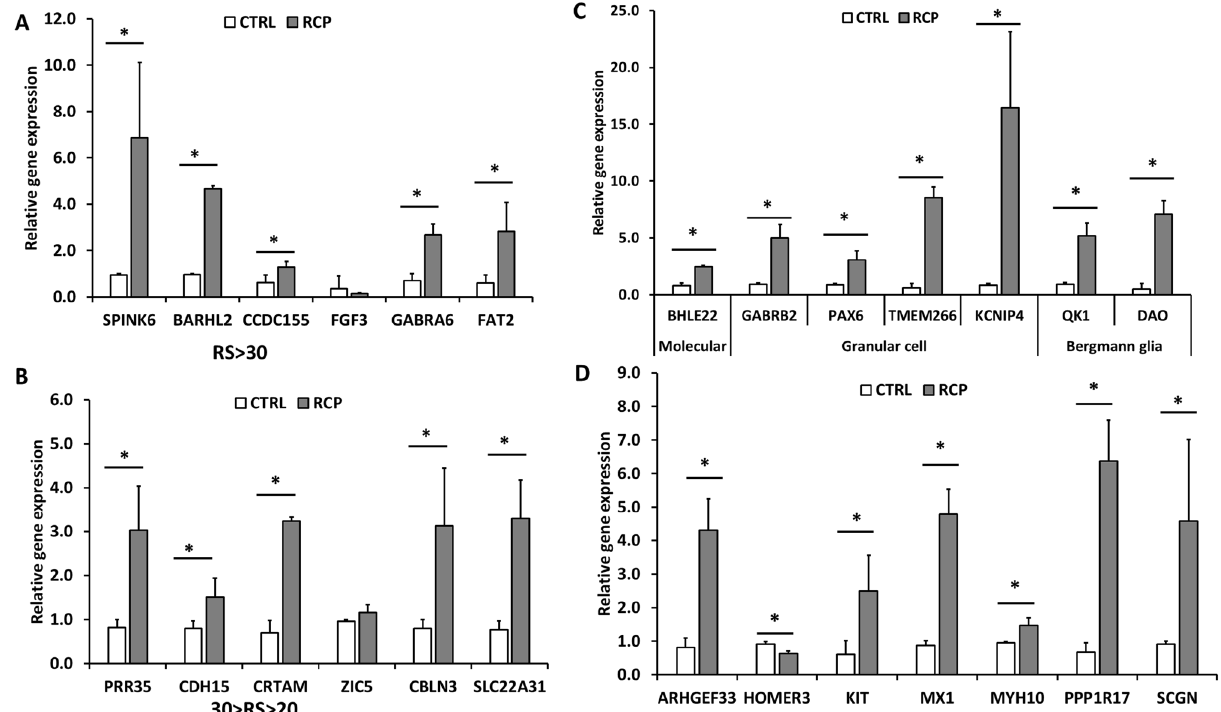
Figure 3. The expression of the top twelve genes with highest RS-score in the human cerebellum and cerebellar layer-specific markers. RT-PCR analysis was performed for day 35 cerebellar organoids derived from hiPSCs. ( A ) The relative expression of genes (mRNA) with RS-score greater than 30. ( B ) The relative expression of genes (mRNA) with RS-score between 30 and 20. The expression of cerebellar layer-specific markers. ( C ) The relative gene (mRNA) expression for the molecular layer, the granule cell layer, and the Bergmann glial cells; ( D ) the relative gene (mRNA) expression for the Purkinje cell layer. * p < 0.05 compared to the control